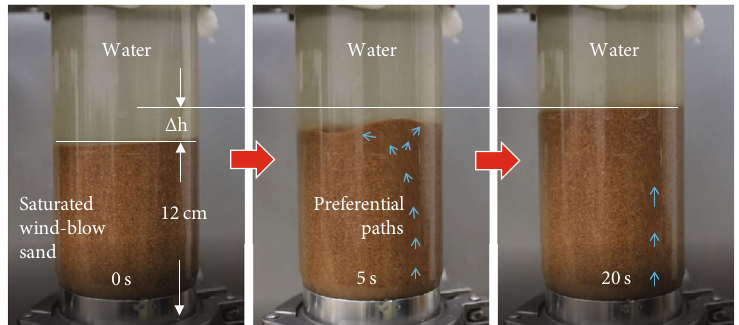
Figure 7: Dynamic evolution of the sand column incipient